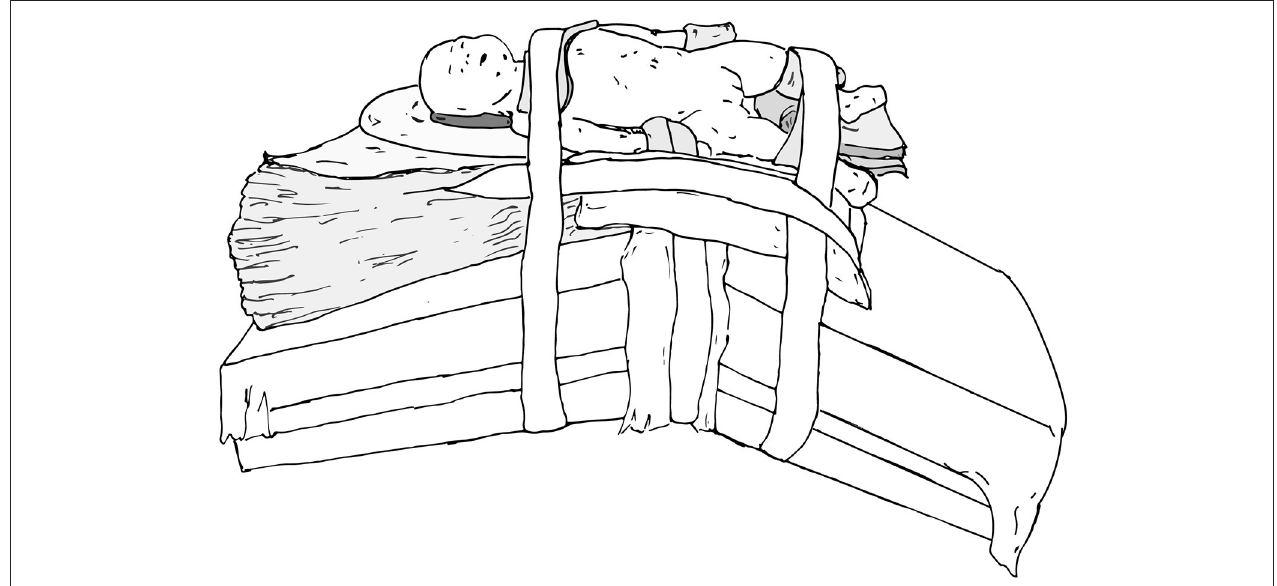
FIGURE 2 | Foam pads are used to elevate small infants (weight < 10kg) ∼ 10cm above the operating table to prevent the robot arms from hitting the table.